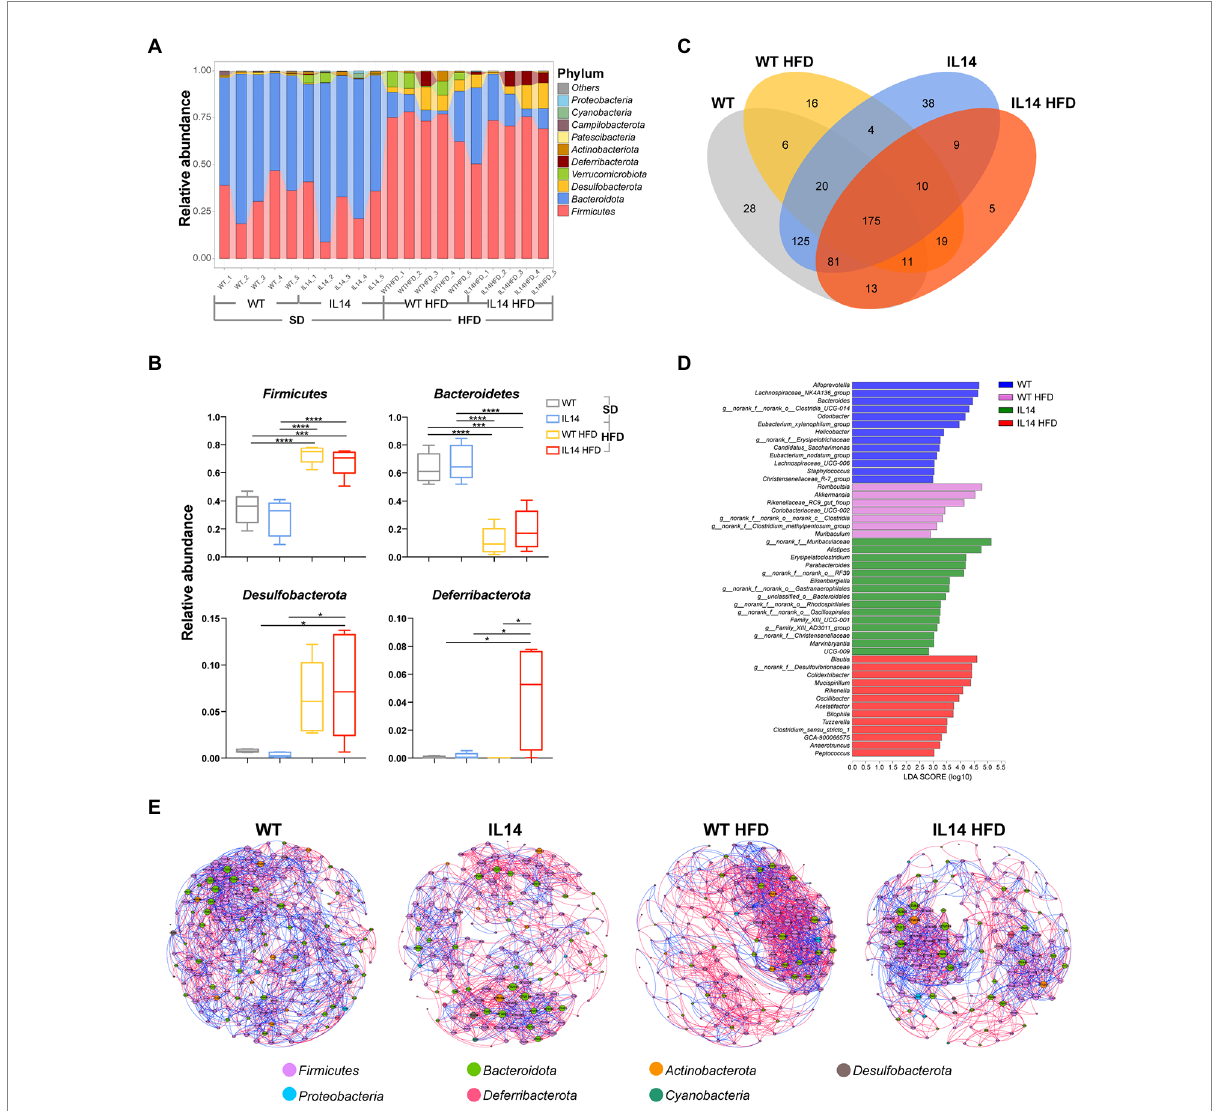
FIGURE 6 HFD affected the composition of the gut microbiota in the IL-14 α TG mice. (A) Fecal microbial composition at the phylum level. (B) The relative abundance of the phyla Firmicutes , Bacteroidetes , Desulfobacterota , and Deferribacterota in the WT, IL14, WT HFD, and IL14 HFD groups. (C) A Venn diagram showing shared or unique OTUs among different groups. (D) Linear discriminant analysis (LDA) effect size (LefSe) analysis of bacterial communities with LDA scores greater than 2. Differences are represented by the color of the most abundant genus (blue is WT; pink is HFD; green is IL14; and red is IL14 HFD). (E) The networks of co-occurring bacterial OTUs in feces of four groups, based on the correlation analysis. The co-occurring networks are colored by phylum. A red edge indicates a positive interaction between two individual nodes, while a blue edge indicates a negative interaction. * p ≤ 0.05; *** p ≤ 0.005; and **** p ≤ 0.001; n = 5 per